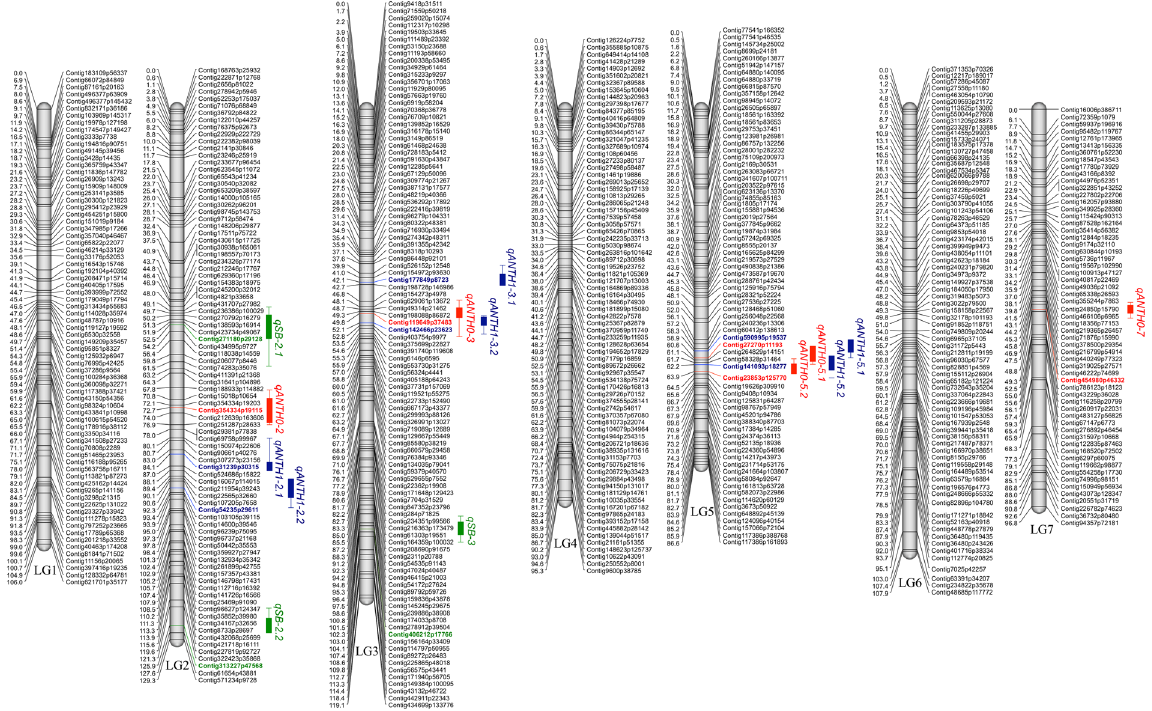
Figure 3. High-density genetic linkage map of the Lens ervoides recombinant inbred line population LR-66 (n = 94, F 9 ) derived from L01-827A × IG 72815 and QTLs controlling resistance to three fungal pathogens. To the right of the linkage groups are SNP markers whose genetic positions in centimorgans are shown to the left of the linkage groups. The marker name indicates the position (p) of a SNP in the contig of the Lens culinaris genome assembly. QTLs conferring resistance to Colletotrichum lentis CT-30 (race 0) are shown as red, to C. lentis CT-21 (race 1) as blue, and to Stemphylium botryosum SB19 as green solid bars with 1-LOD confidence intervals. Vertical lines with caps on bars represent 2-LOD likelihood intervals.